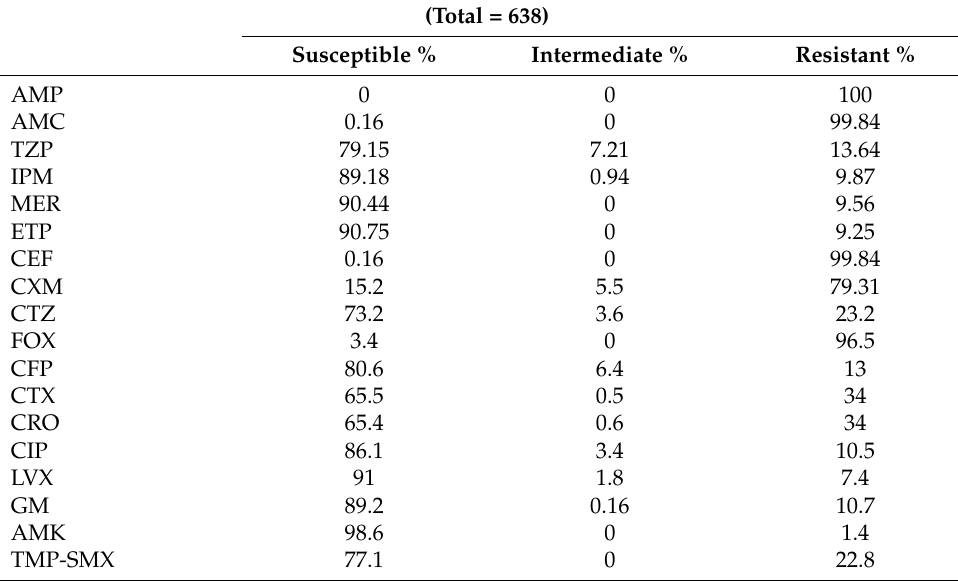
Table 4. Antimicrobial susceptibility test results for E. cloacae